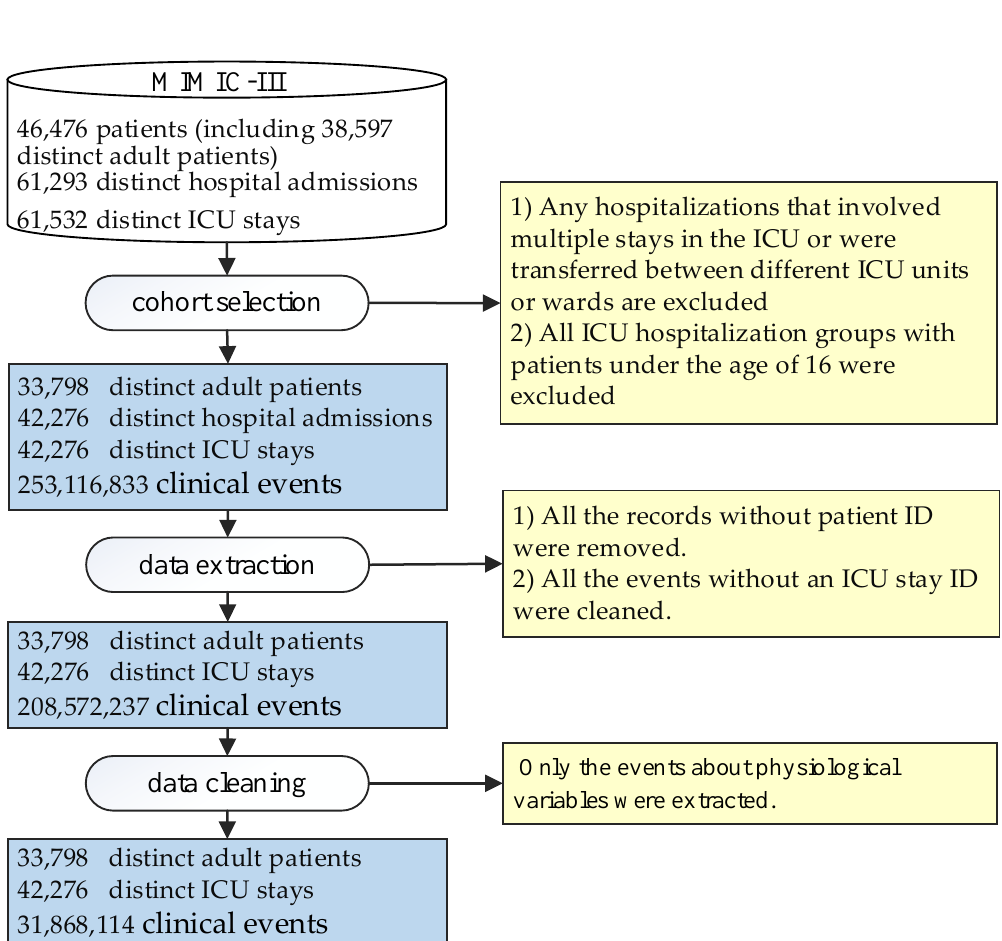
Figure 2. The cohort selection, data extraction, and data-cleaning process of the experimental dataset.